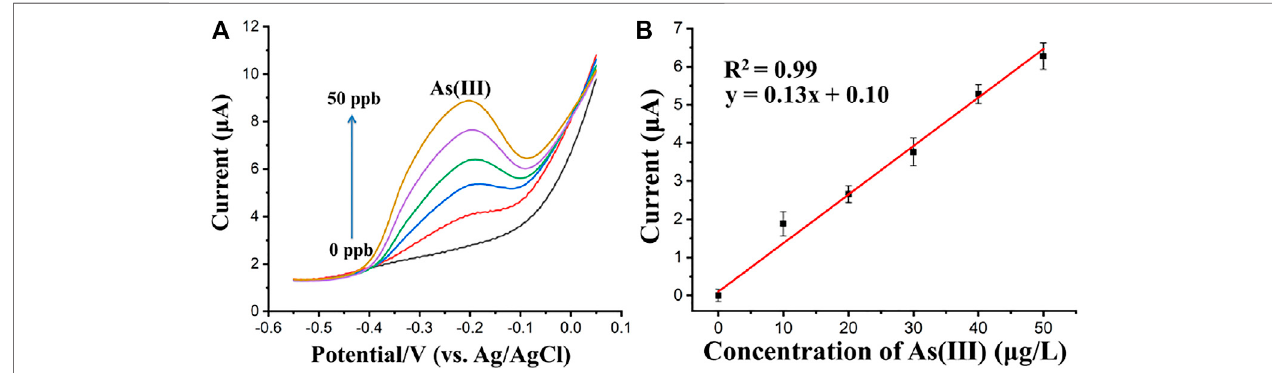
FIGURE 9 |(A) Square wave anodic stripping voltammograms ofAs( Ⅲ ) (0, 10, 20, 30, 40, and 50 μ g/L). (B) The calibration curvesfor As( Ⅲ ). Each data point is an average of 3 measurements from 3 electrodes and error bars represent ±1 standard deviation.